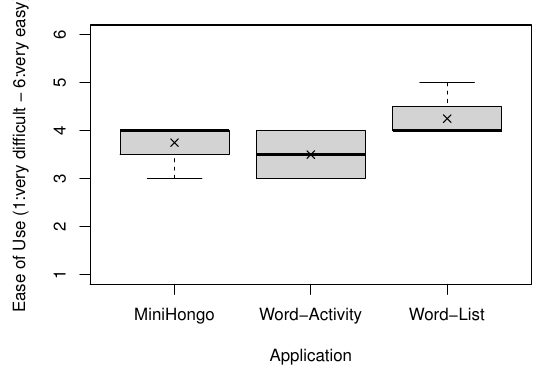
Figure 13. Ease of